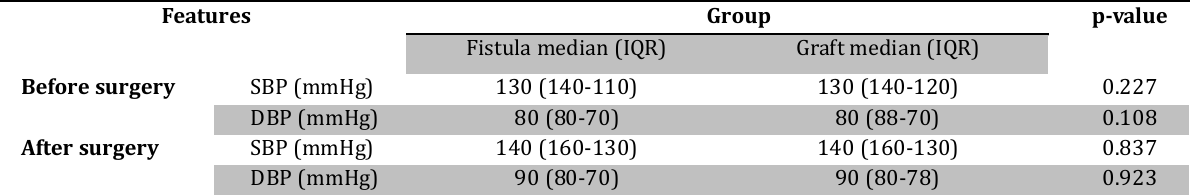
Table 4. Comparing diastolic and systolic blood pressure before and after surgery between functional and unfunctional